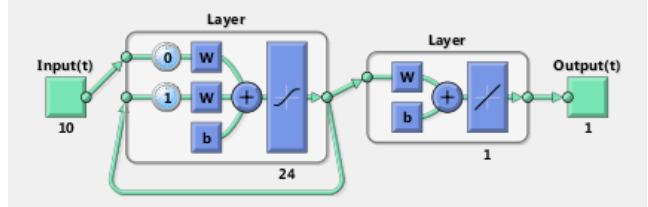
Figure 7. The structure of Elman neural network.